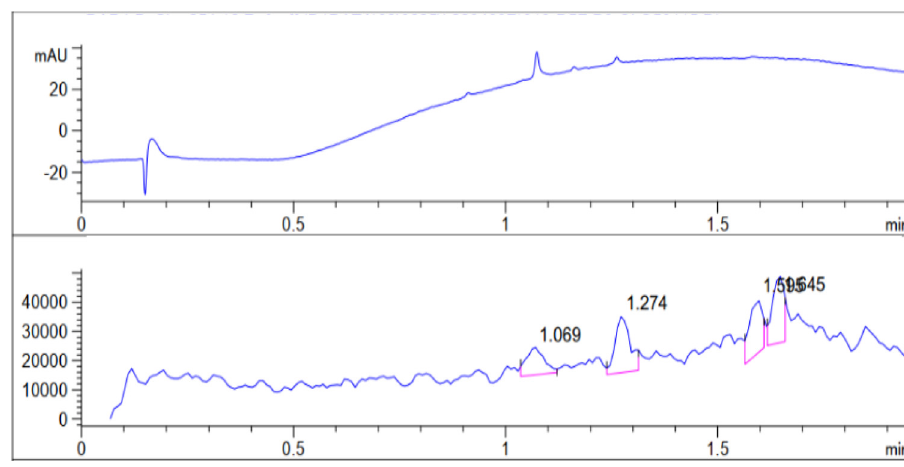
Figure 1: Chromatogram pro fi le of polyphenol - rich fraction from the leaves of Withania adpressa Coss. ex Batt.